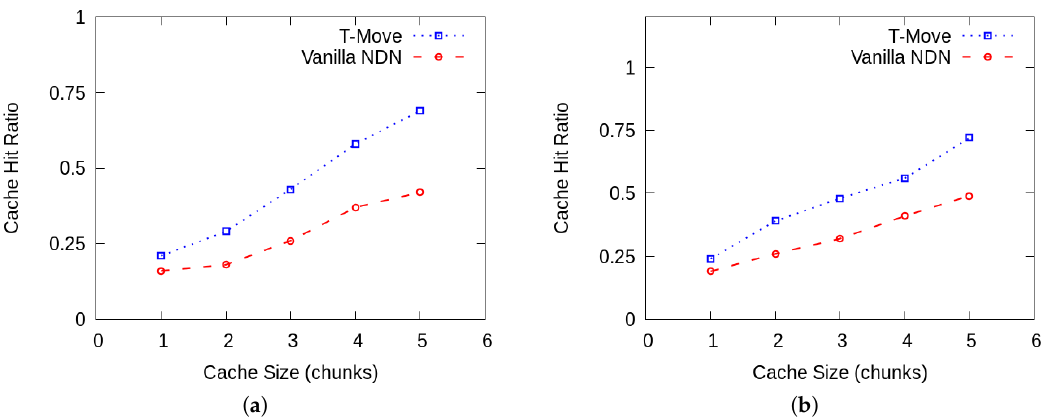
Figure 8. ( a ) Change in Cache Hit Ratio with Cache Size (Topology 1); ( b ) Change in Cache Hit Ratio with Cache Size (Topology